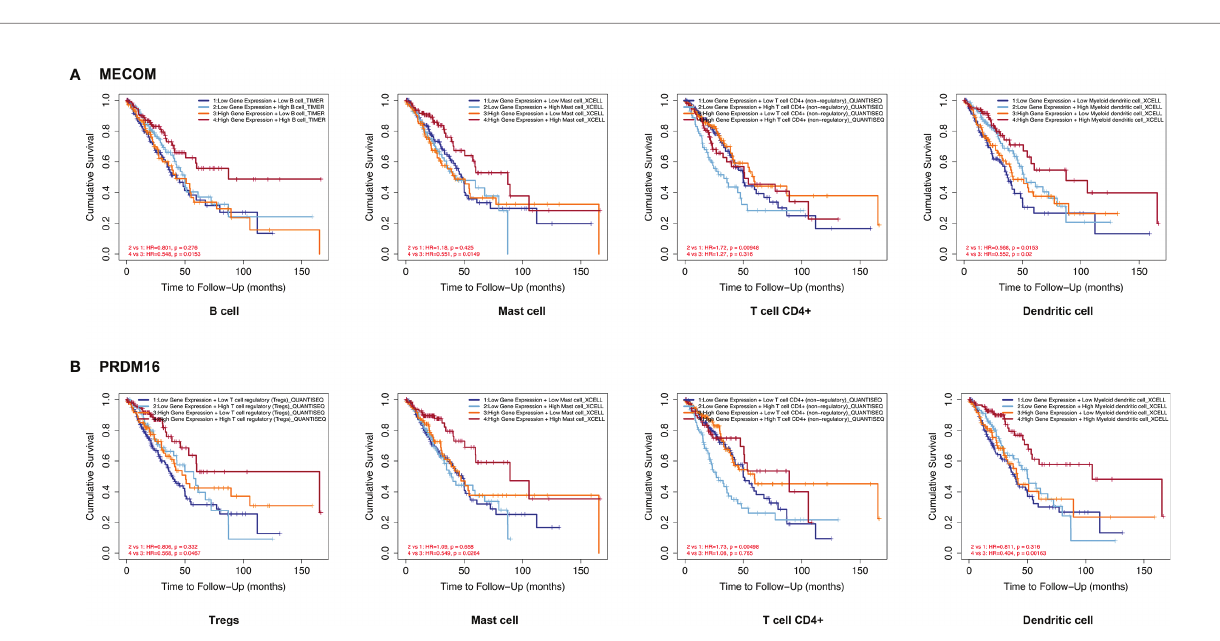
FIGURE 7 | Correlation between MECOM- (A) and PRDM16-related (B) immune cell expression and prognosis in LUAD. MECOM, MDS1 and EVI1 complex locus, also called PRDM3; PRDM16, PR domain containing 16, also called MEL1; LUAD, lung